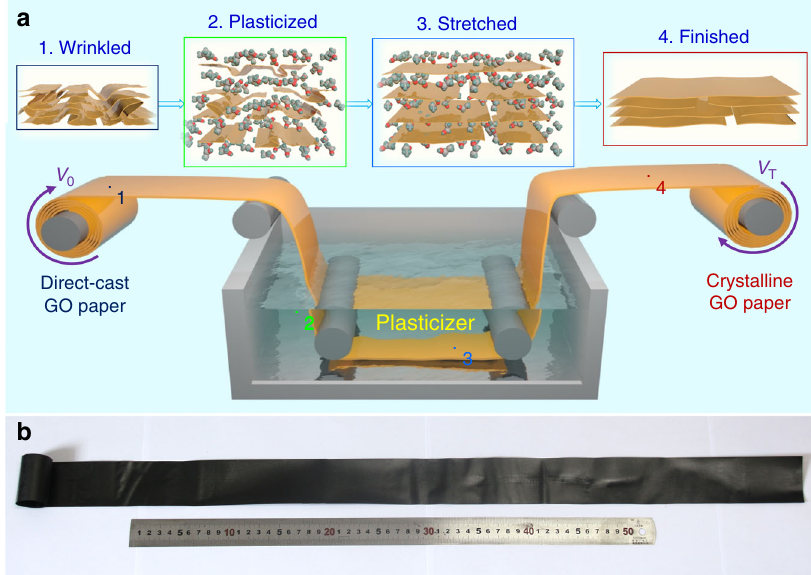
Fig. 1 Production of highly crystalline graphene oxide papers by plasticization stretching method. a Schematic of the continuous IMP stretching apparatus. b Photograph of the meter-long GOP after continuous IMP stretching.